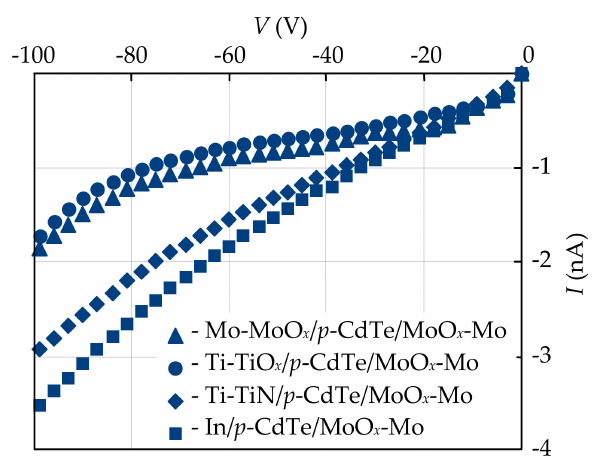
Figure 3. Reverse I-V characteristics of the CdTe-based Schottky-diode detectors with one MoO x contact and the second one made from different materials: MoO x (triangles), TiO x (circles), TiN (diamonds), and In (squares).